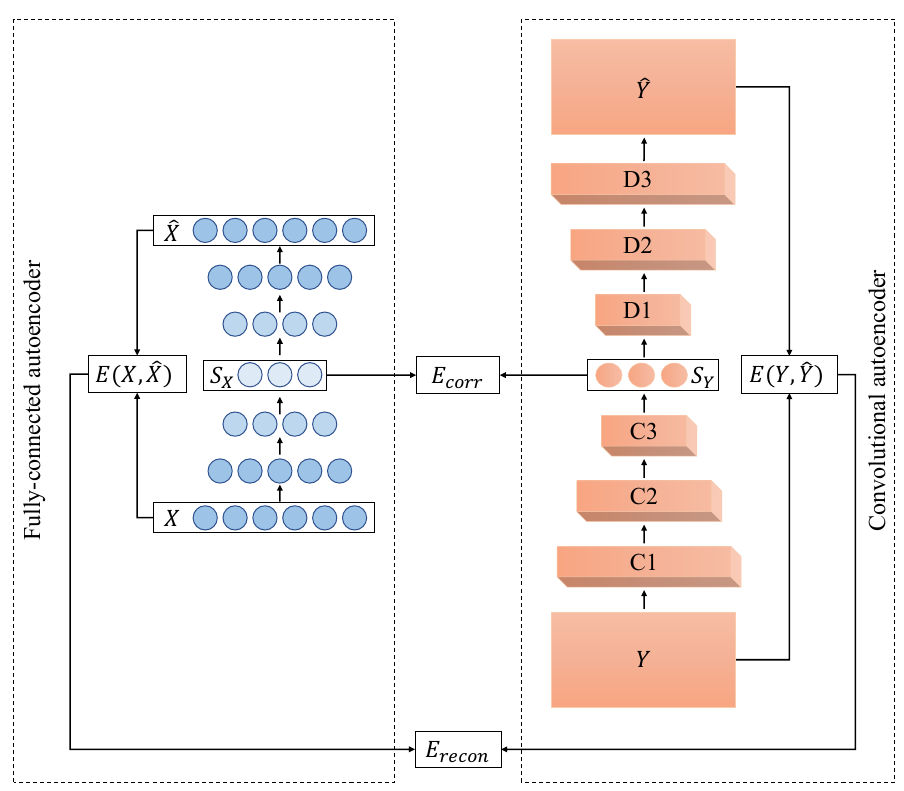
Figure 2. Architecture of asymmetric PDAE: The left autoencoder is a fully-connected autoencoder, which takes feature vectors from X as input. The right autoencoder is a CAE, which takes images from Y as input. Both autoencoders have a fully-connected layer with three neurons as their code